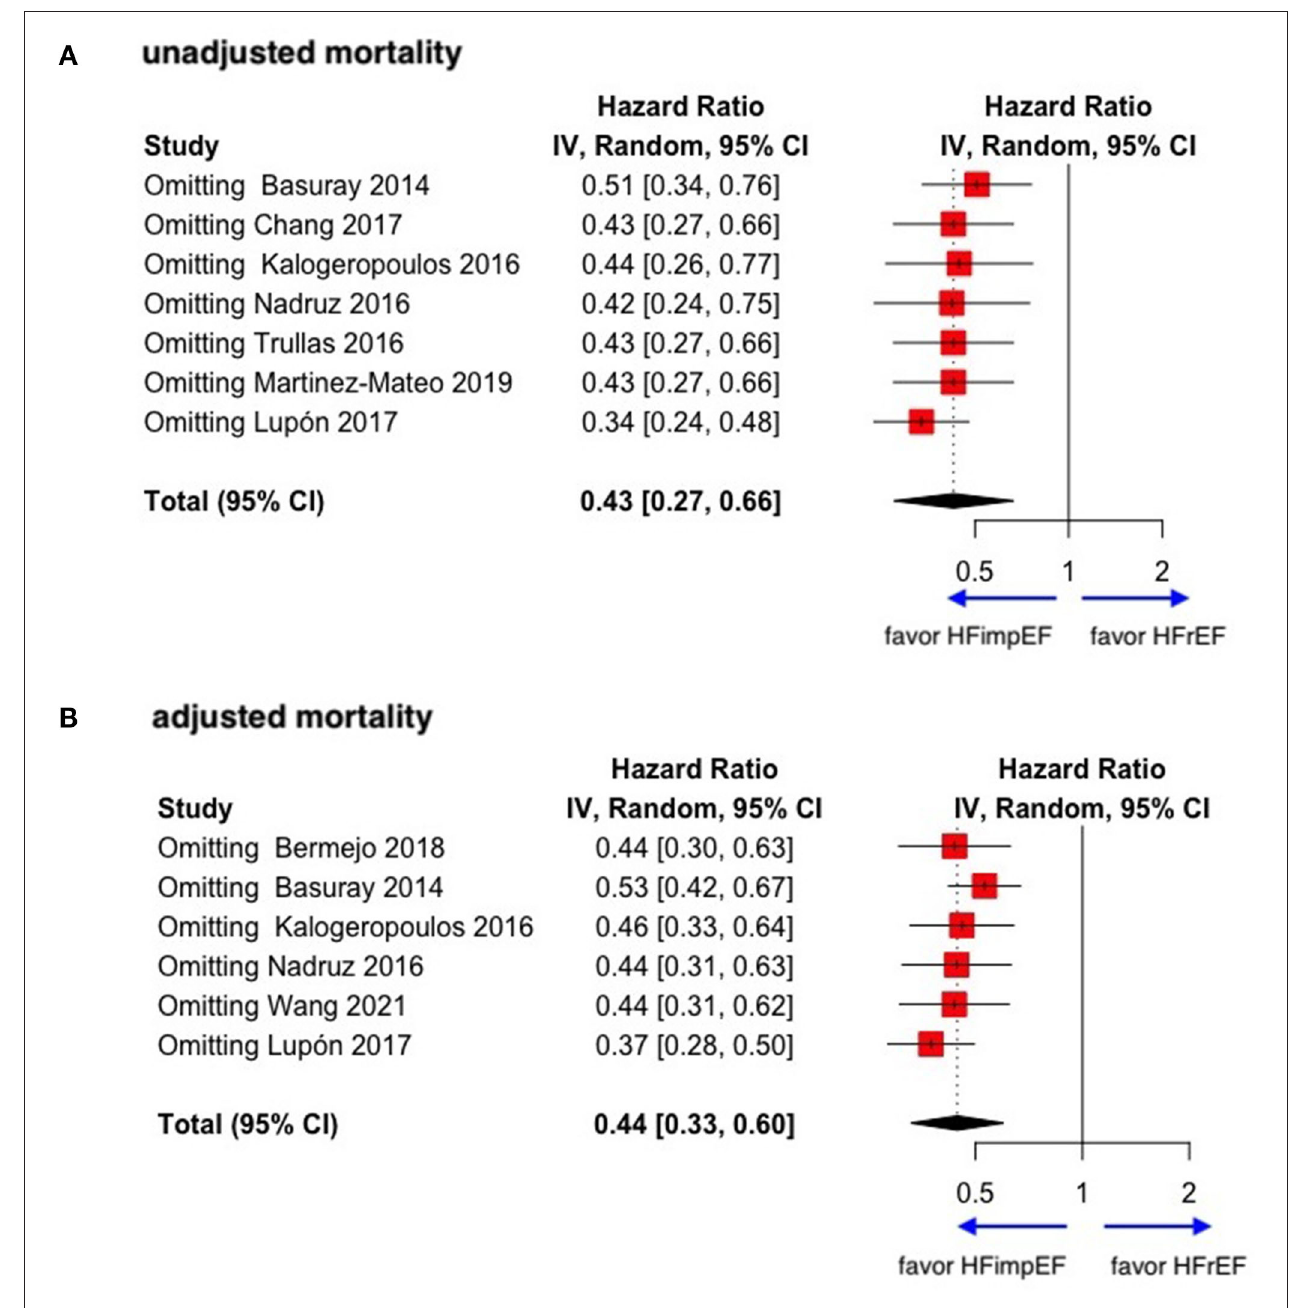
FIGURE 3 | Sensitive analysis of unadjusted and adjusted mortality in patients between HFimpEF and HFrEF. (A) Unadjusted mortality. (B) Adjusted mortality.